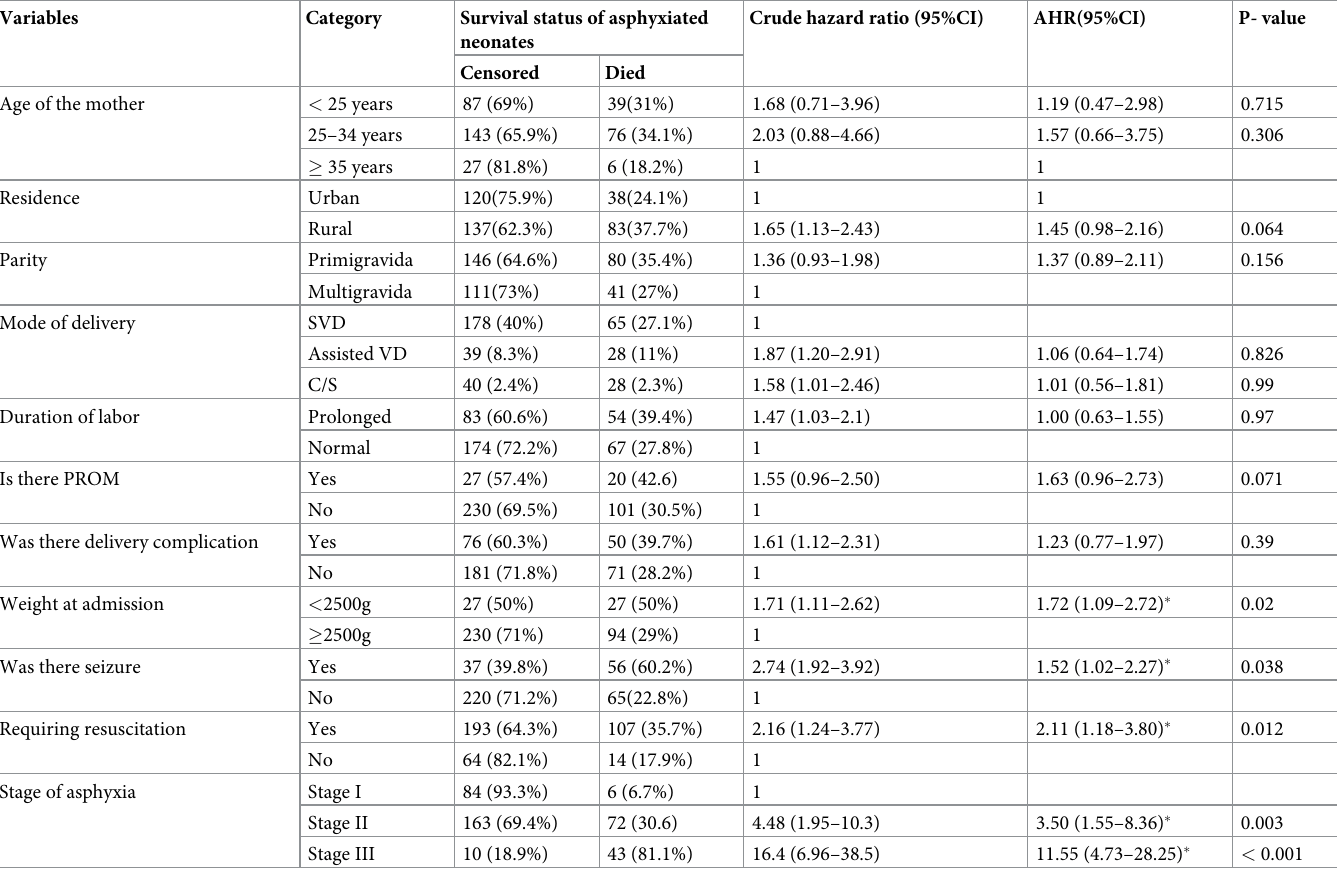
Table 5. Predictors of mortality among asphyxiated neonates admitted to the NICU of DCSH, Amhara region, Northeast Ethiopia (N = 378).